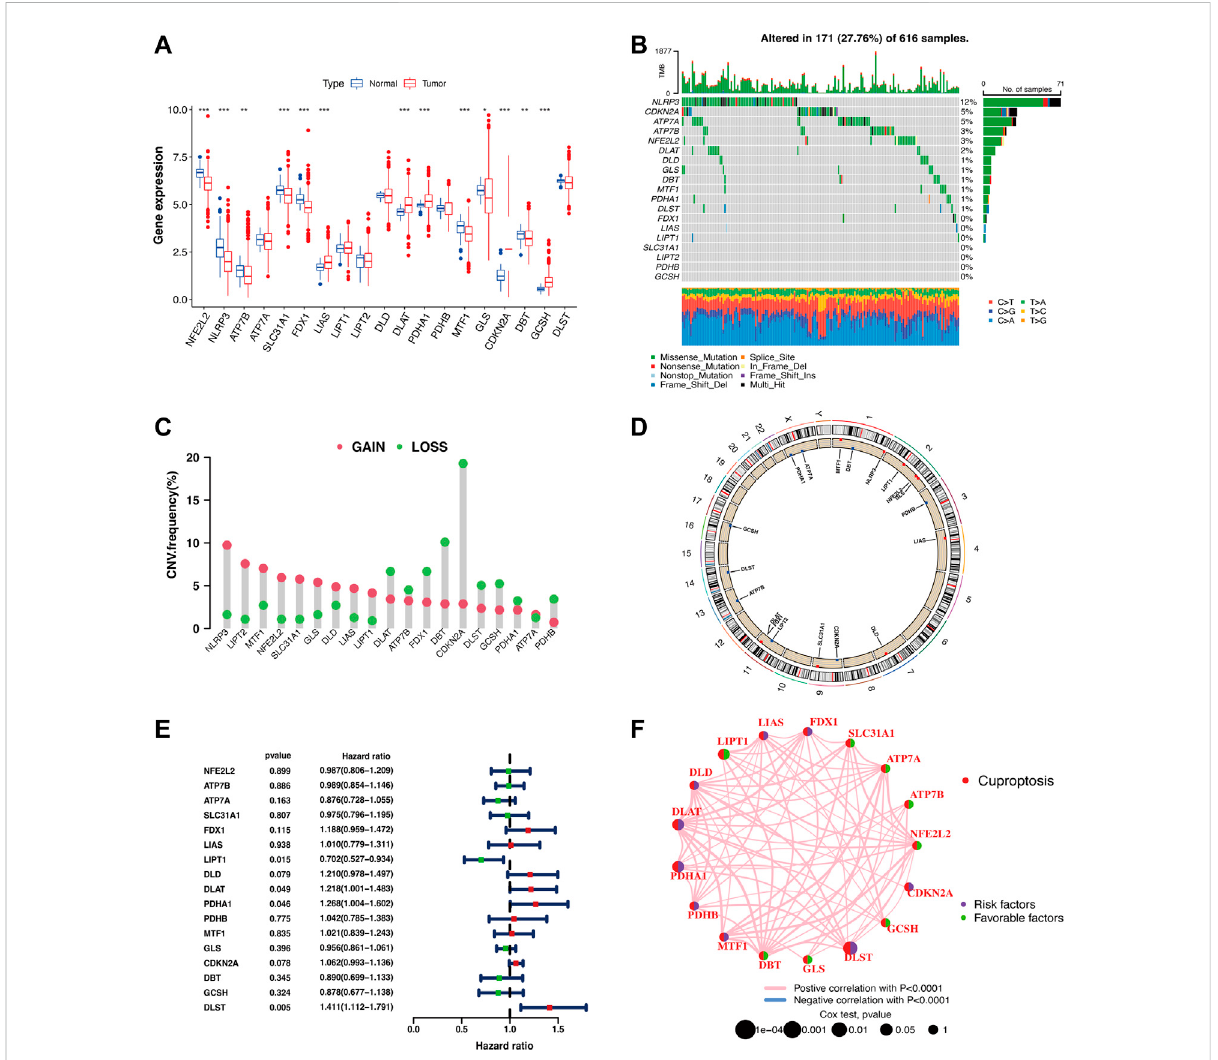
FIGURE 1 Identi fi cation of CRGs and detection of mutations in LUAD. (A) Cuproptosis-related gene expression in normal cells and LUAD tumor cells (Wilcoxontest;* p < 0.05;** p < 0.01;*** p < 0.001). (B) ThewaterfallplotdisplaysthemutationfrequencyofCRGsinLUADsamples. (C) CNVofCRGs inLUADsamples. (D) CNVlocationsofCRGsarelabeledonthechromosome(reddots:CNVgainfrequencyishigher;bluedots:CNVlossfrequency is higher). (E) Forest plot for the univariate Cox regression analysis of CRGs associated with clinical prognosis in LUAD patients. (F) Prognostic correlation between